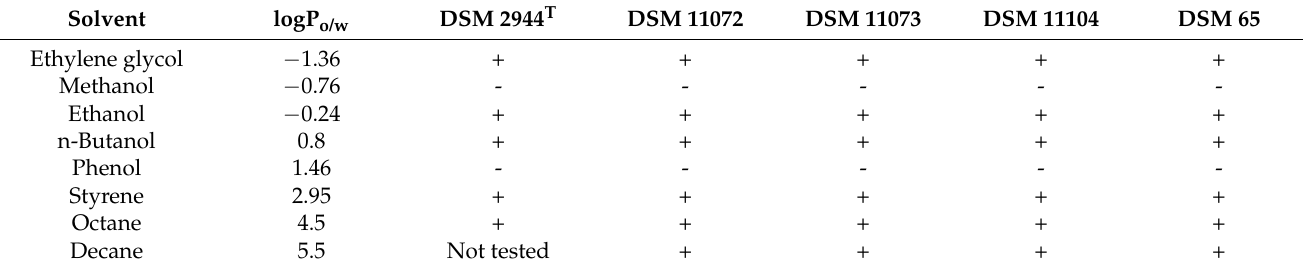
Table 8. Growth of tested strains on different solvents as the sole carbon source. An MSM medium was supplied with the solvent in comparable concentrations. Cultures were incubated for up to three days in airtight serum flasks, during which changes in OD600 were measured. Rising OD determined